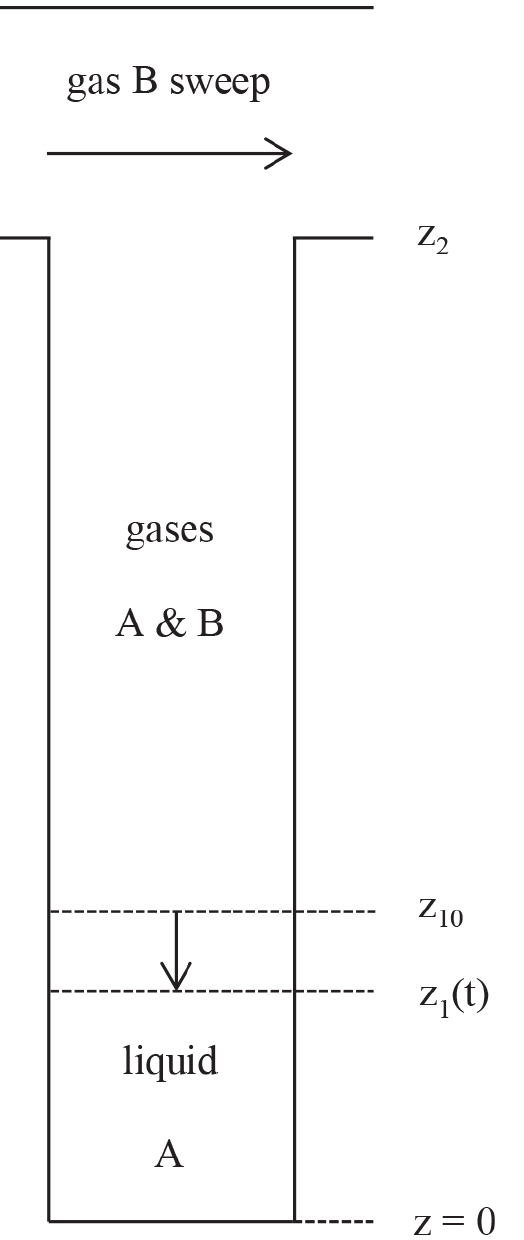
Figure 4. Classic sketch of the Stefan diffusion column showing the liquid and gas compartments. 68,69 The operating modality depicted is that of the descending liquid-gas interface without liquid replace- ment. Pure volatile liquid A is charged initially to a height z 10 . Its level falls to z 1 (t) after an elapsed time t following the start of the evaporation-diffusion process. Liquid A evaporates at the interface and its vapor ascends through stagnant gas B (air) until it reaches the top of the column at z 2 . A steady and slow gas B sweep at the top maintains the concentration of A very close to zero at that loca- tion. The binary gas diffusivity of A in B can be calculated from fundamental mass transport principles applied to gas A and experi- mental interfacial descent versus time data (refer to the text for details). Symbol definitions can be found in the